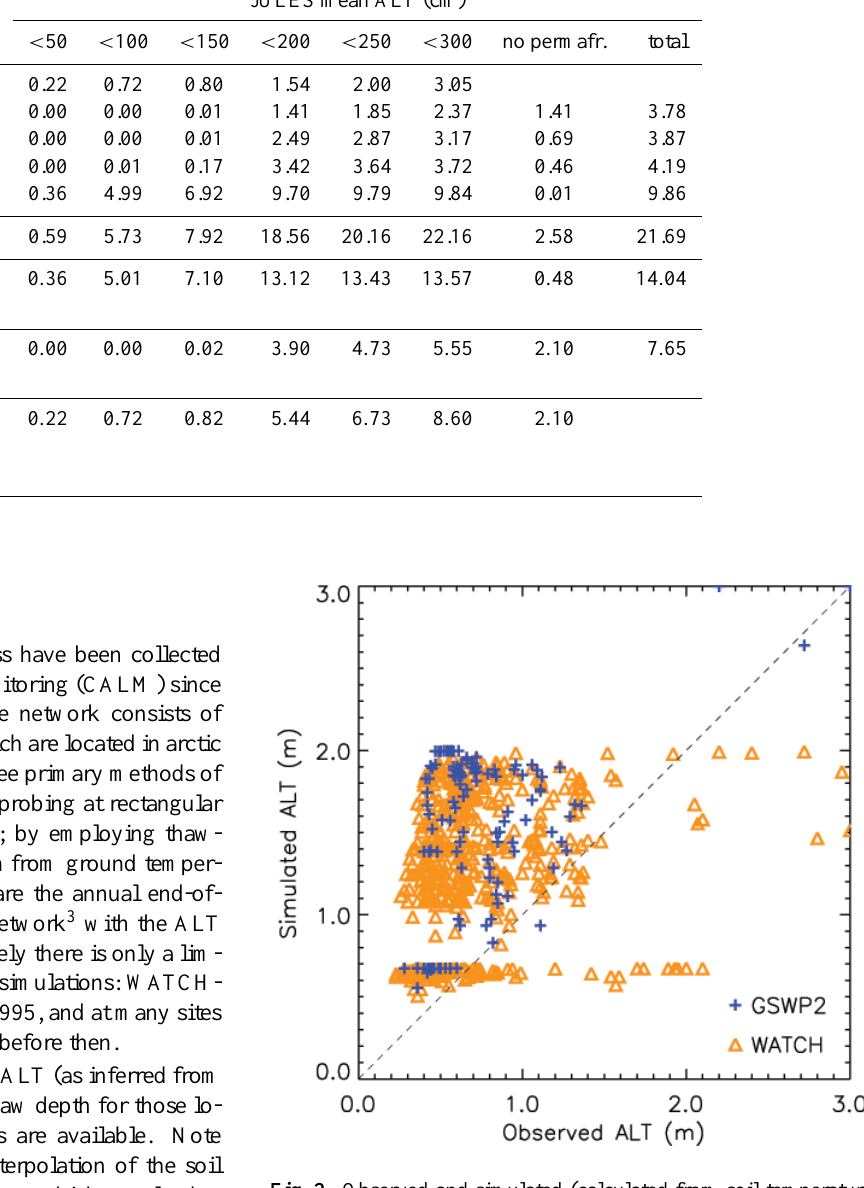
relatively coarse with the bottom layer stretching over 2